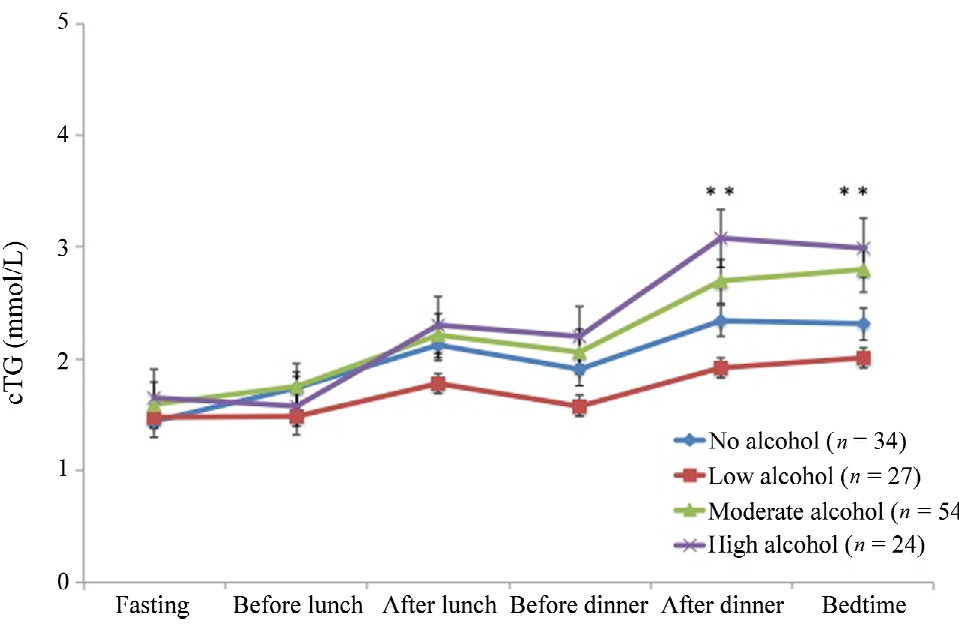
Figure 1. Diurnal capillary triglyceride patterns according to alcohol intake. Data are shown as mean ± SEM. ** Significant differences in cTG for a specific time-point ( p for trend